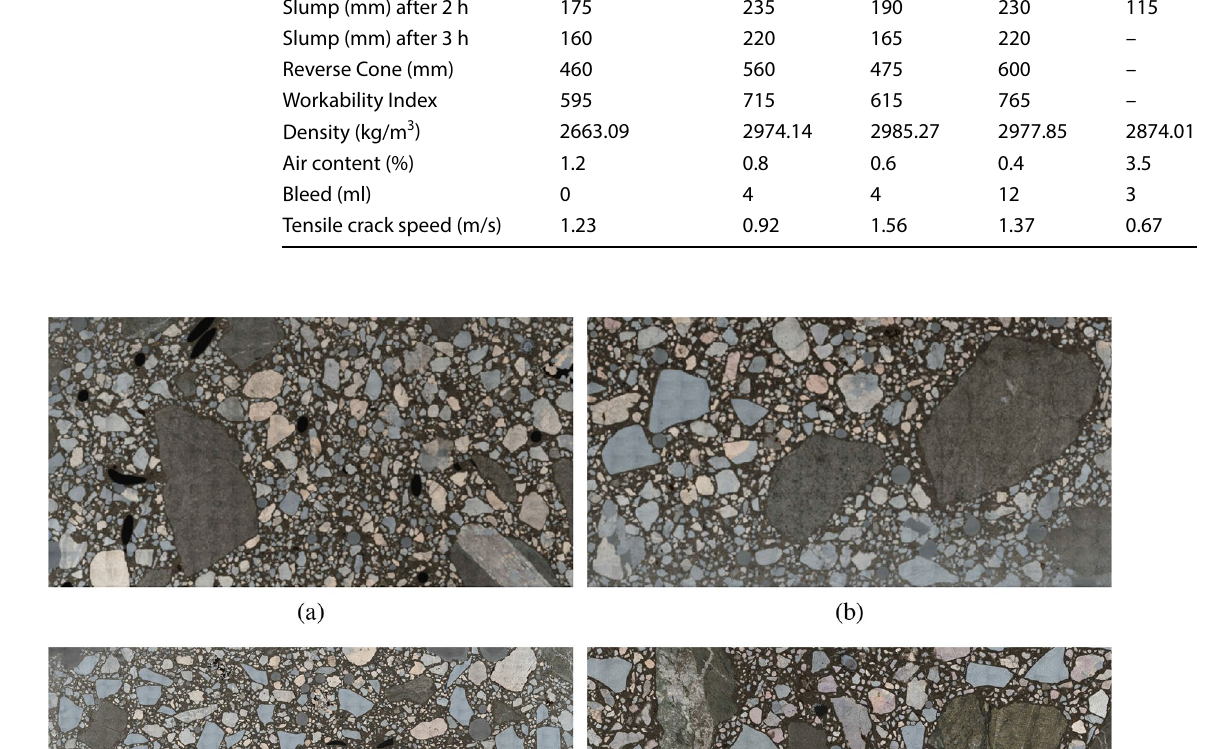
Table 5 Summary of the basic properties in all the tested shotcrete mixes